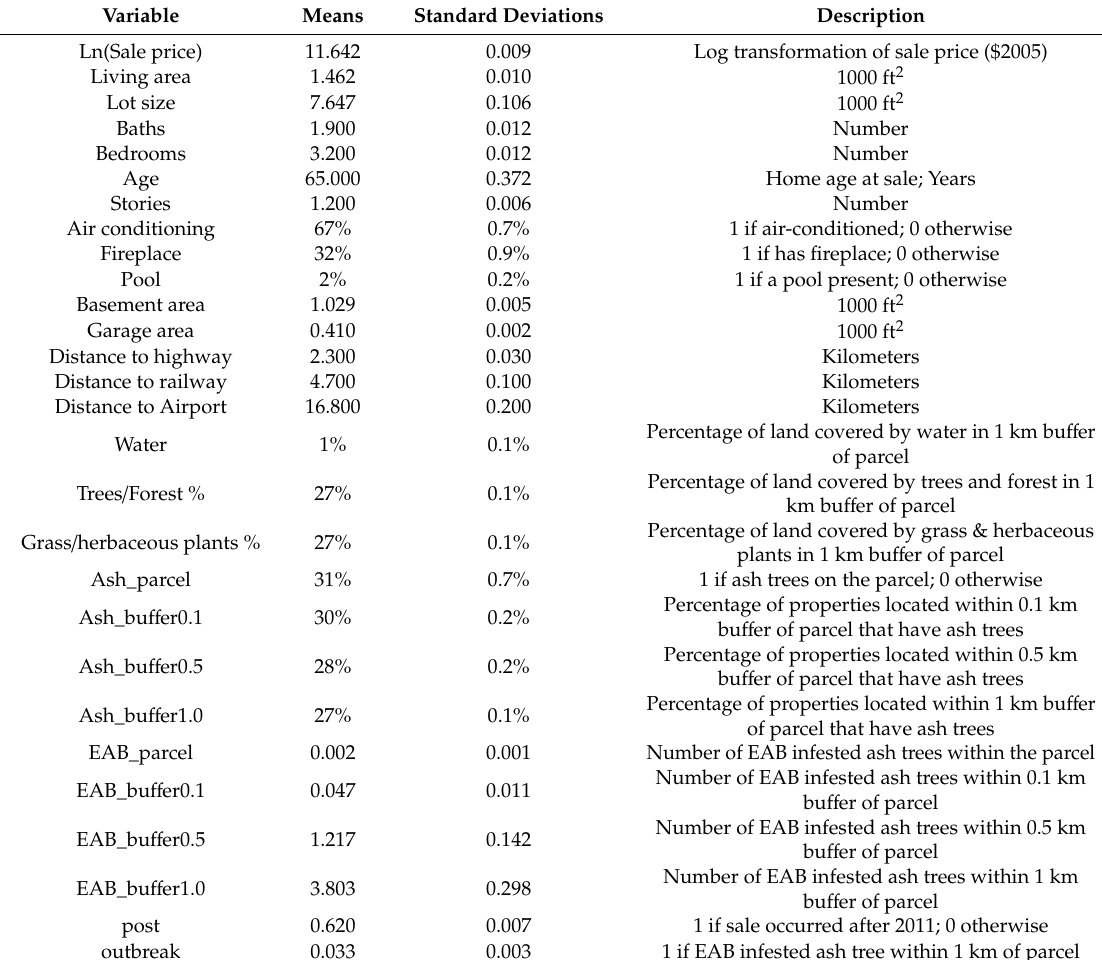
Table 1. Descriptive Statistics of Property Characteristic Variables ( n = 4502). (EAB = emerald ash